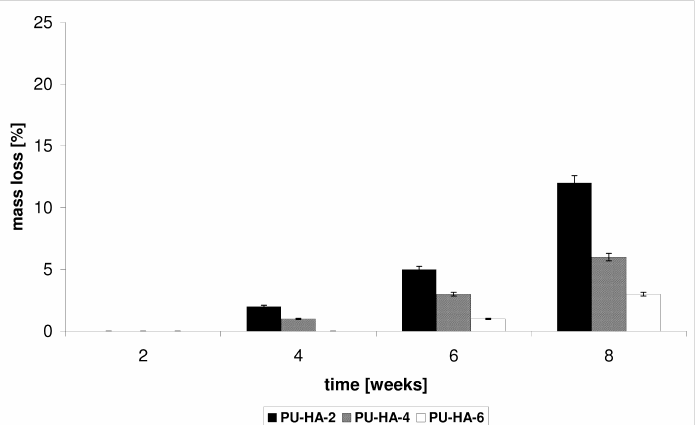
Figure 10. Mass loss of the PU-HA-2, PU-HA-4 and PU-HA-6 composites after the biodegradation process.